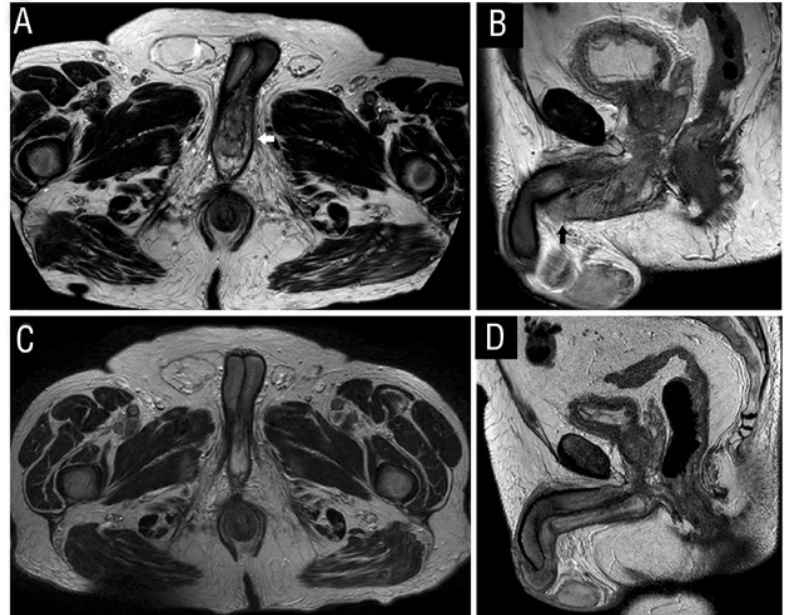
Figure 2 (A-D) – MRI of the urethral metastasis (T2WI). Axial (A) and sagittal (B) images show an area of marked T2 heterogeneity involving the bulb (white arrow in A) and proximal body of the penis (black arrow in B) with a gross cylindrical shape. This lesion has an estimated total extension of 10 cm. It is presumably centred in the urethra (penile, bulbous and membranous) with loss of the normal anatomic planes between the urethra and the surrounding corpus spongiosum. The described lesion corresponds to an area with heterogeneous contrast enhancement after gadolinium injection and restricted diffusion (not shown). Followup MRI of the pelvis after three therapeutic cycles with sunitinib revealed a reduction of the lesion’s extension and less heterogeneity, with a better definition of the anatomical planes (C and D). There was no significant restriction to diffusion on DWI (not